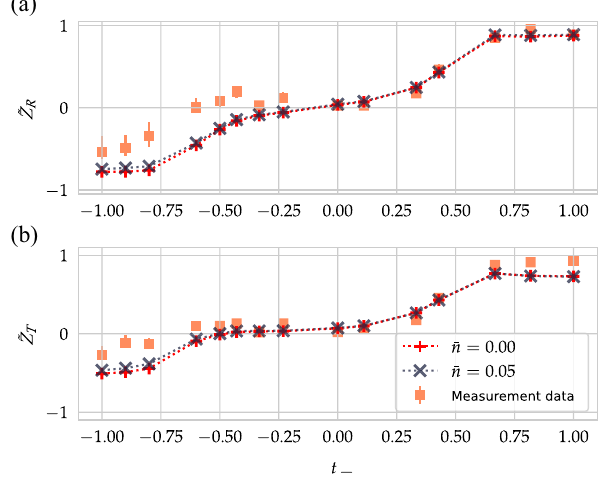
FIG. 11. Simulated heating of the motional modes for mean phonon numbers ¯ n ¼ 0 . 00 and ¯ n ¼ 0 . 05 of the initial state. The time reference is established via the average laser-pulse length t